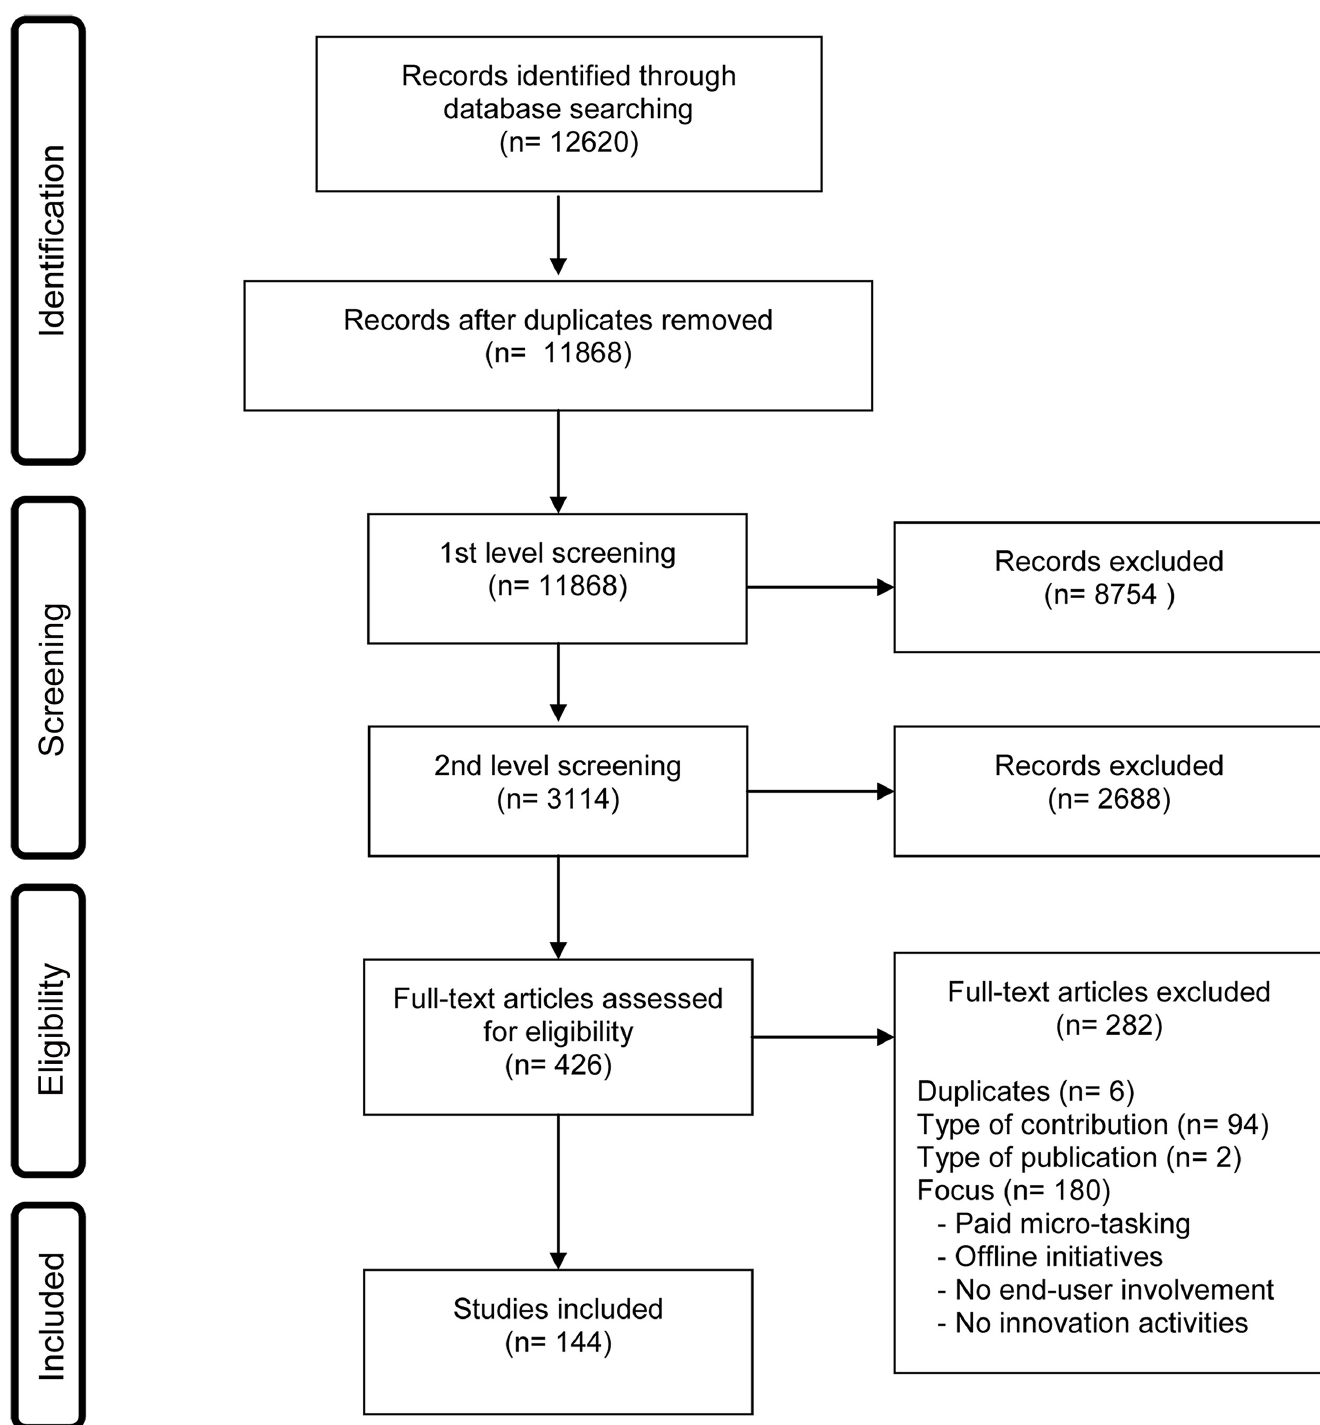
Fig 1. Flowchart.